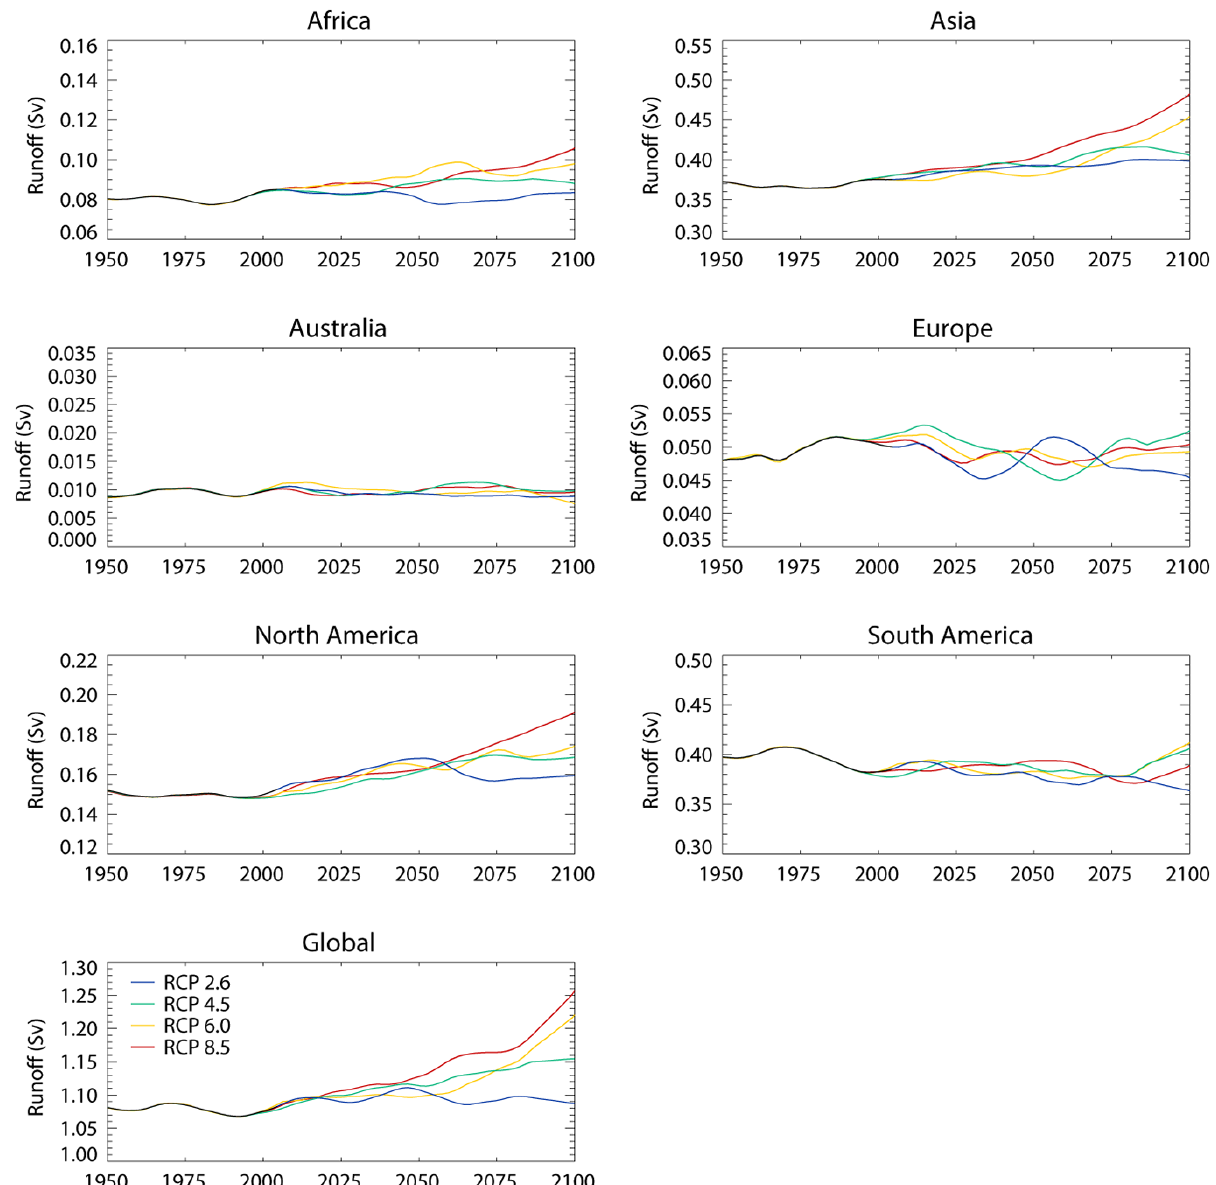
Figure 18. Total river outflow (Sverdrups) for Africa, Asia, Australia, Europe, North America, South America and the globe, simulated by HadGEM2-ES under historical forcing prior to 2000 and thereafter under RCP2.6 (blue), RCP4.0 (cyan), RCP6.0 (yellow) and